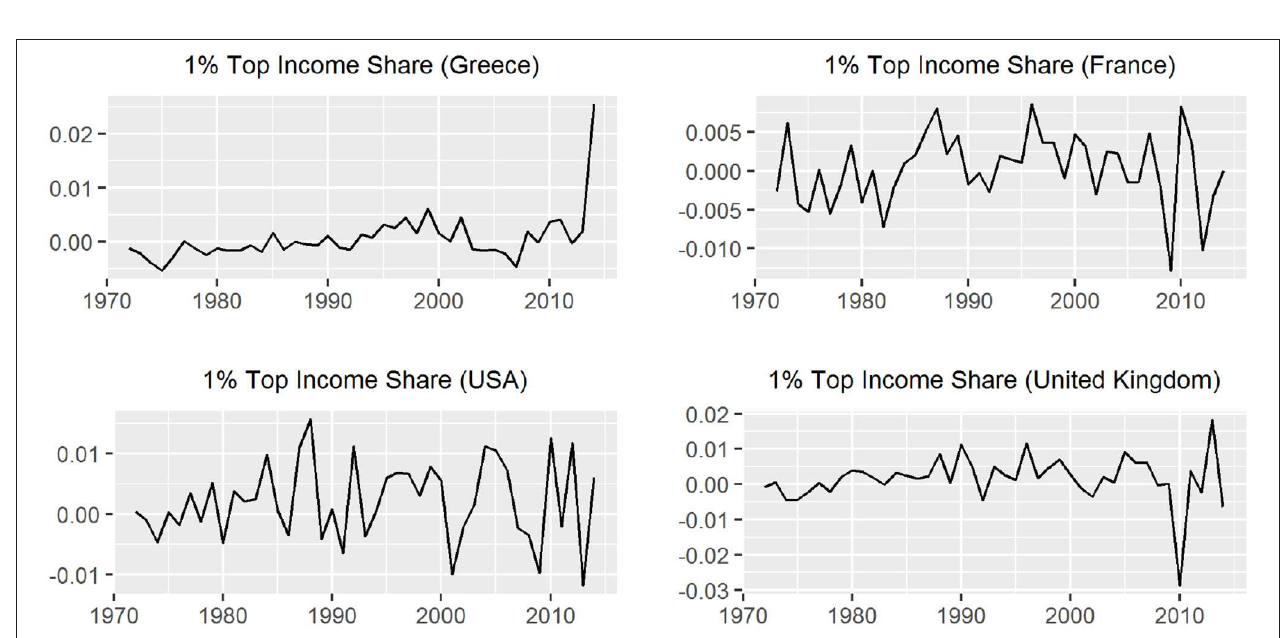
FIGURE 4 | The evolution of 1% top income shares.